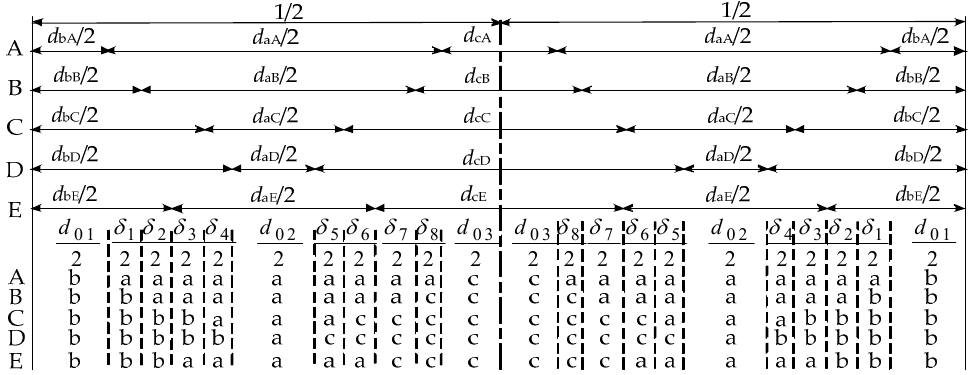
Figure 3. Arrangement of a switching sequence.